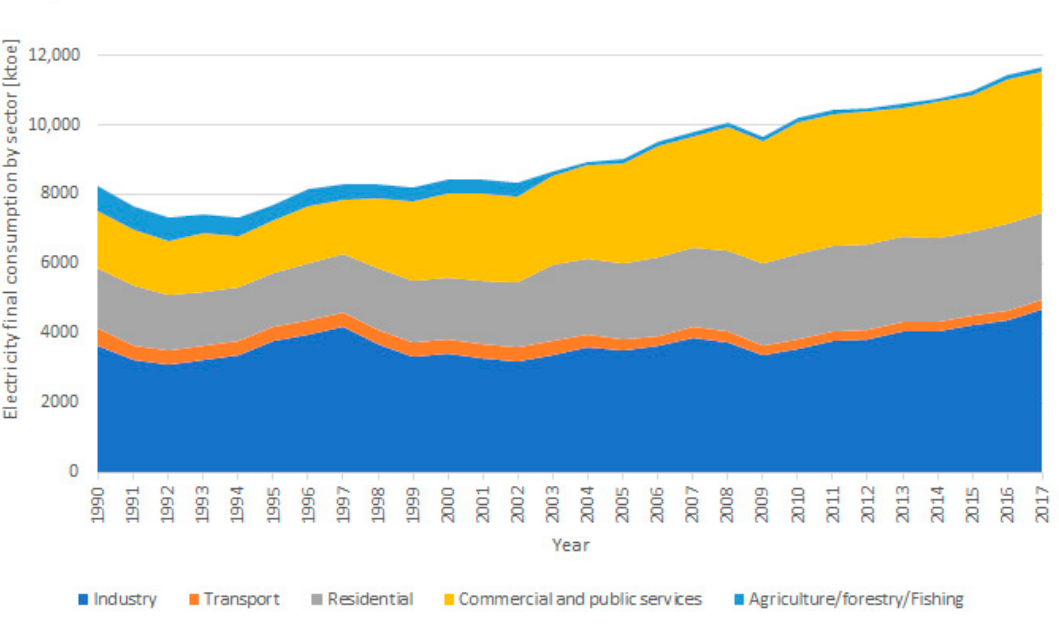
Figure 5. Consumption of electricity by year 1990–2017, ktoe, source: own study based on the data [31,32].